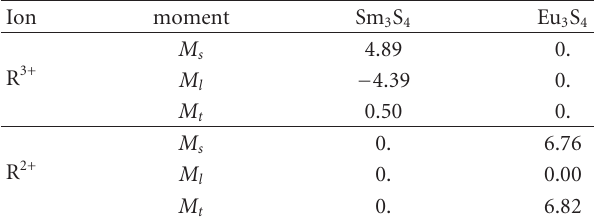
Table 11: The calculated spin M s , orbital M l , and total M t